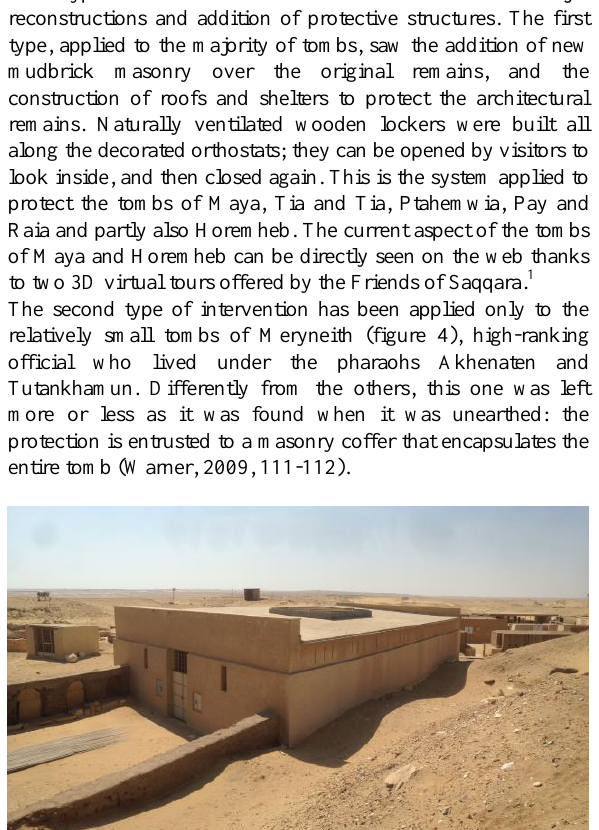
Figure 5. The Tomb of Pay and Raia after the restoration works (from www.sharm-club.com/egypt/ancient-tombs/pay-raia-